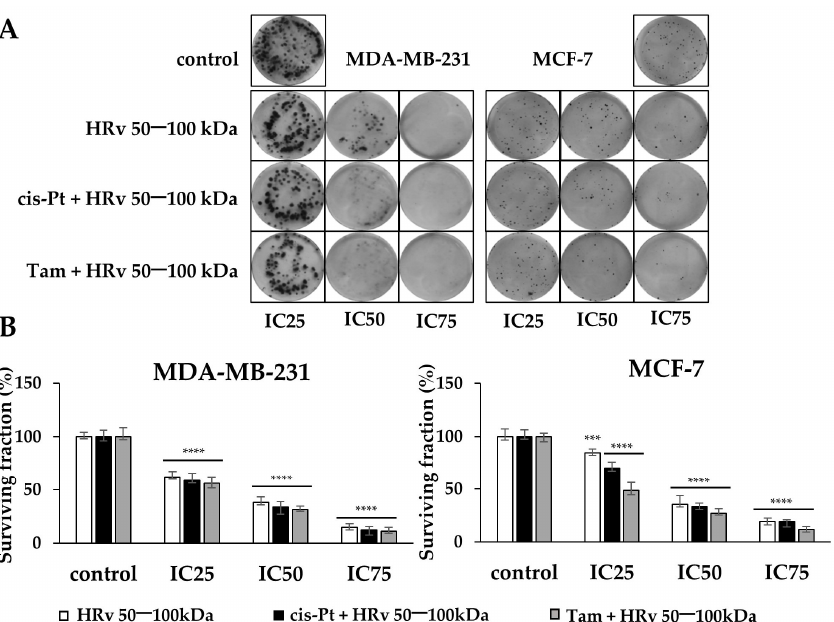
Figure 7. Hemolymph fraction 50-100 kDa and combination treatments with cisplatin (cis-Pt) and tamoxifen (Tam) inhibit colony formation in human breast cancer cells. ( A ) Representative images of colony formation assay conducted in MDA-MB-231 and MCF-7 cells as described in Materials and Methods. Cells were treated with HRv 50–100 kDa and combinations of HRv 50–100 kDa with cisplatin and tamoxifen at indicated IC concentrations for 48 h. After 10 days for MDA-MB-231 and 18 days for MCF-7, the colonies were stained with crystal violet and the number of colonies was counted; ( B ) Quantification of the surviving fraction is represented as the mean ± SD of three independent experiments. For statistical analysis, Dunnett’s multiple comparisons test in ordinary two-way ANOVA was used to compare the mean of each column with the mean of the control column. Probability values were considered significant at *** p < 0.005, **** p < 0.001. Bar graphs represent the means of three independent experiments.